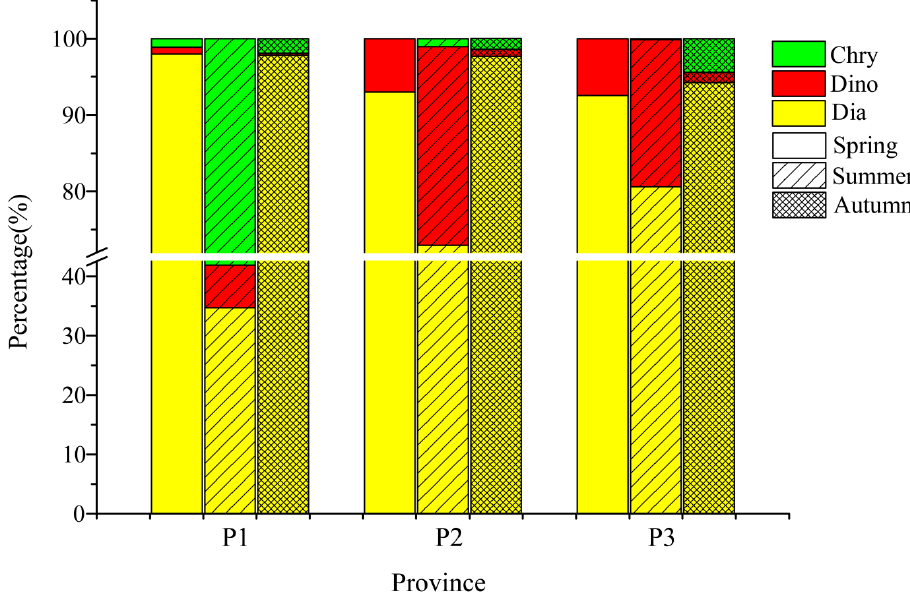
Figure 11. Seasonal percentage of different phytoplankton taxa in different seasons.